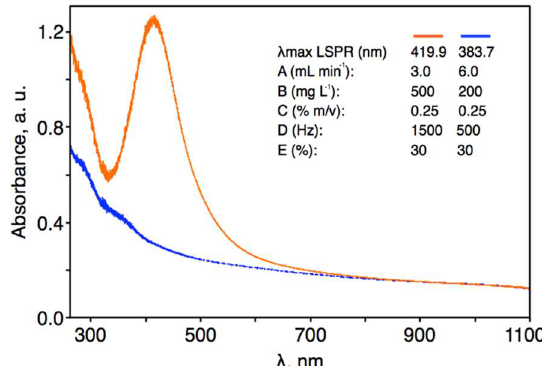
Figure 5. UV/Vis absorption spectra of silver nanoparticles (AgNPs) synthesized with the aid of the pulse-modulated radio-frequency atmospheric-pressure glow discharge (pm-rf-APGD) plasma-reaction under experimental conditions providing the smallest (condition 1) and the largest (condition 2) AgNPs according to the developed response surface regression model.